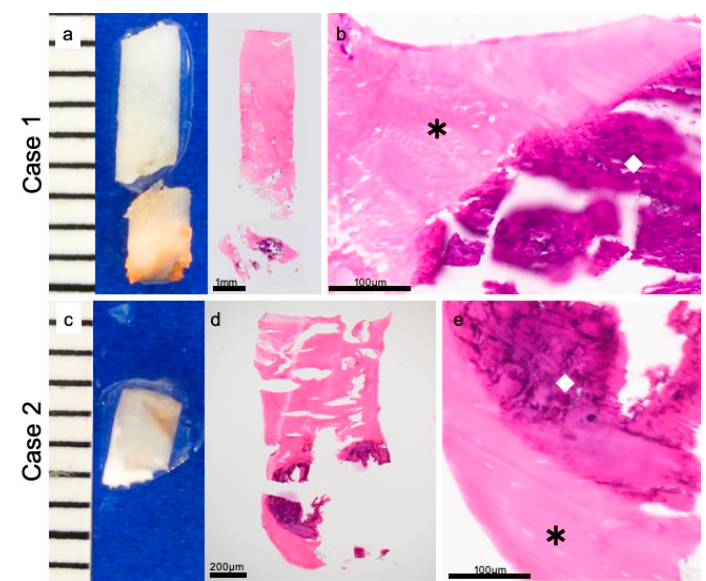
Figure 2. Direct contact of material and bone. Case 1: ( a ) macro findings and hematoxylin-eosin